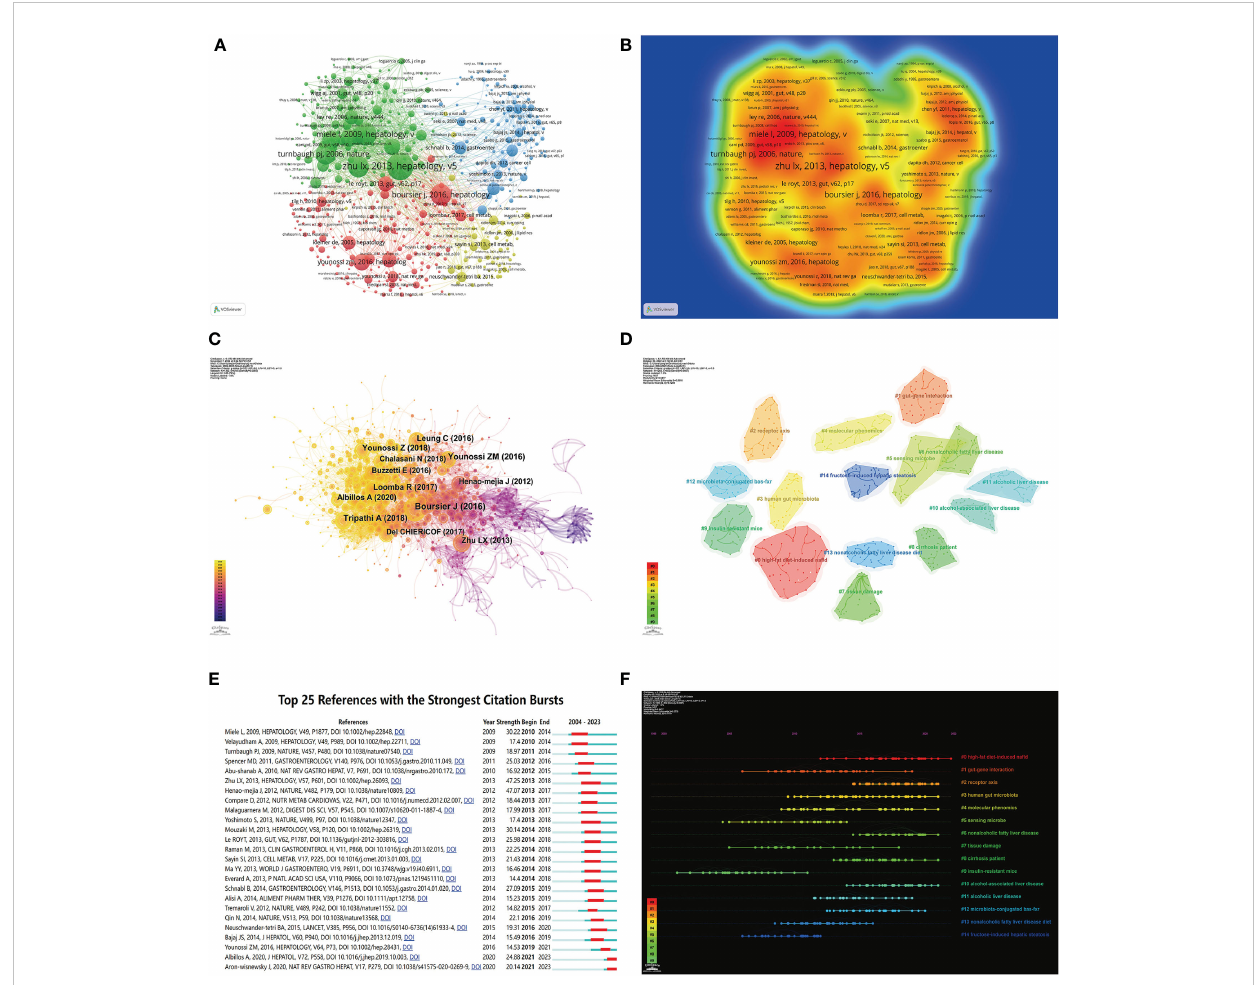
FIGURE 7 Visualization of co-cited literature on the gut-liver axis in NAFLD. (A) References co-citation network in the gut-liver axis in NAFLD based on VOSviewer. (B) The density visualization of co-cited references based on VOSviewer. (C) References co-citation network in the gut-liver axis in